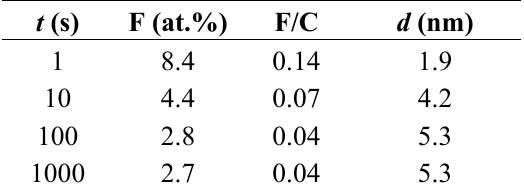
Table 1. Fluorine concentration and calculated protein film thickness versus incubation time in albumin solution for the CF plasma-treated PET sample. 4